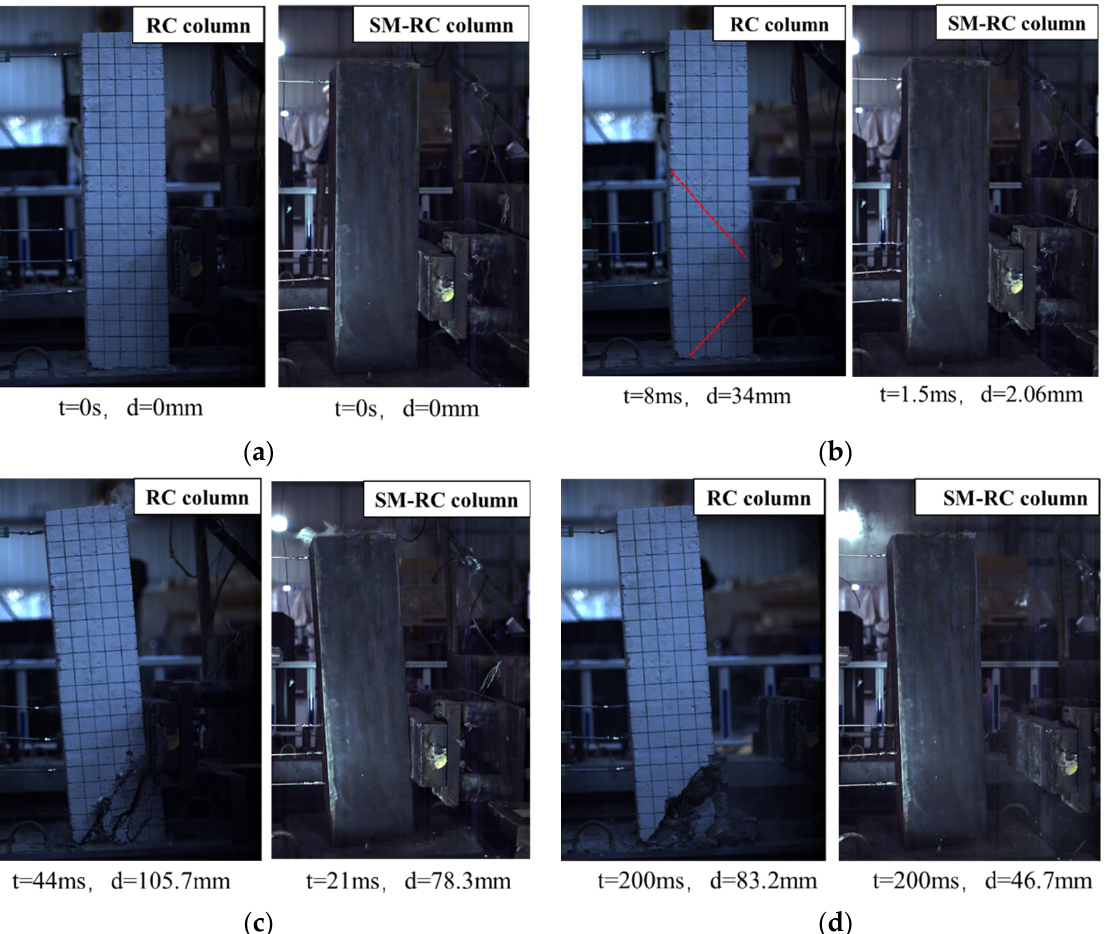
Figure 7. Impact process of experiment specimen. ( a ) Initial moment. ( b ) Peak force moment. ( c ) Peak displacement moment. ( d ) Final state.